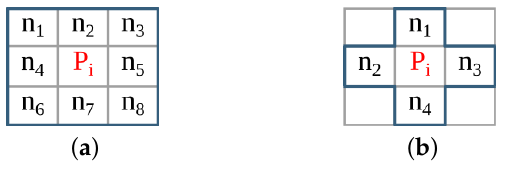
Figure 17. A 3 × 3 sliding window ( a ) an 8-connective (square) kernel ( b ) a 4-connective (cross)